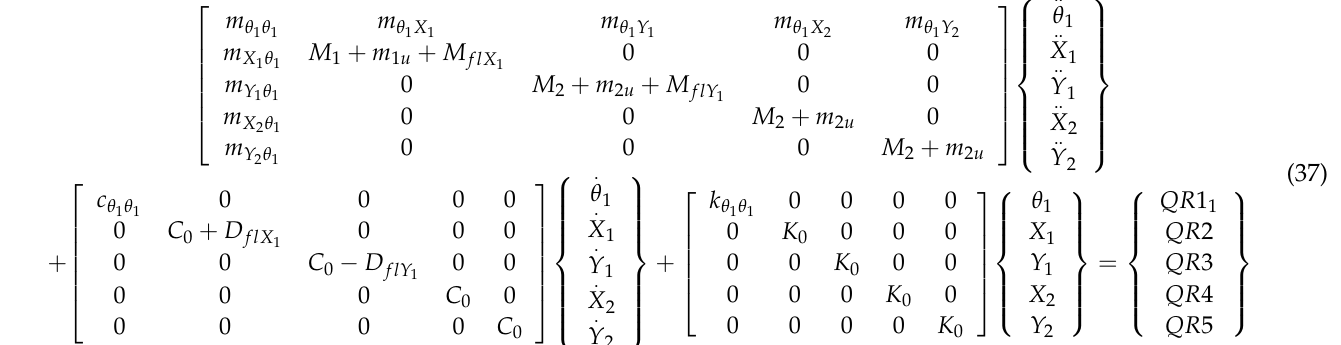
Figure 4. Model of the driveshaft–stator contact ( a ) Rub-impact diagram ( b ) Wet rub-impact configuration. The variation of the minimum hydrodynamic thickness is illustrated with respect to time, for high input shaft speed and low Reynolds in Figure 5b. Upon substitution of Equations (9)–(11) with Equations (30), (31) and (36) and performing requisite differentiation using Lagrange’s principle, the full system differential equations in each generalized coordinate frame are